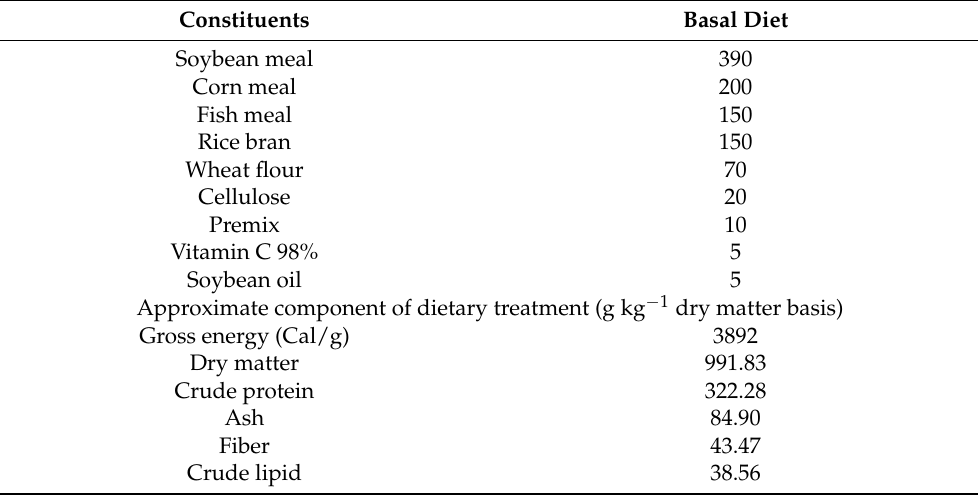
Table 1. Approximate composition and formulation of the experimental diets (g kg − 1 ).